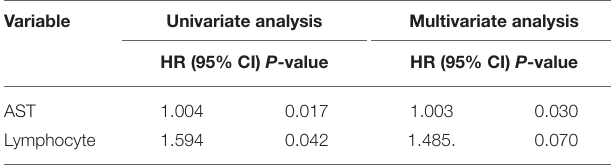
TABLE 4 | Cox regression analyses for predictors of